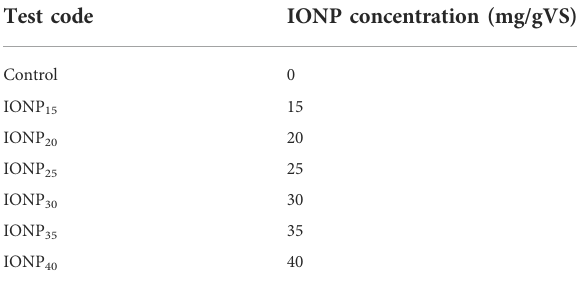
FIGURE 1 BMP testing equipment.